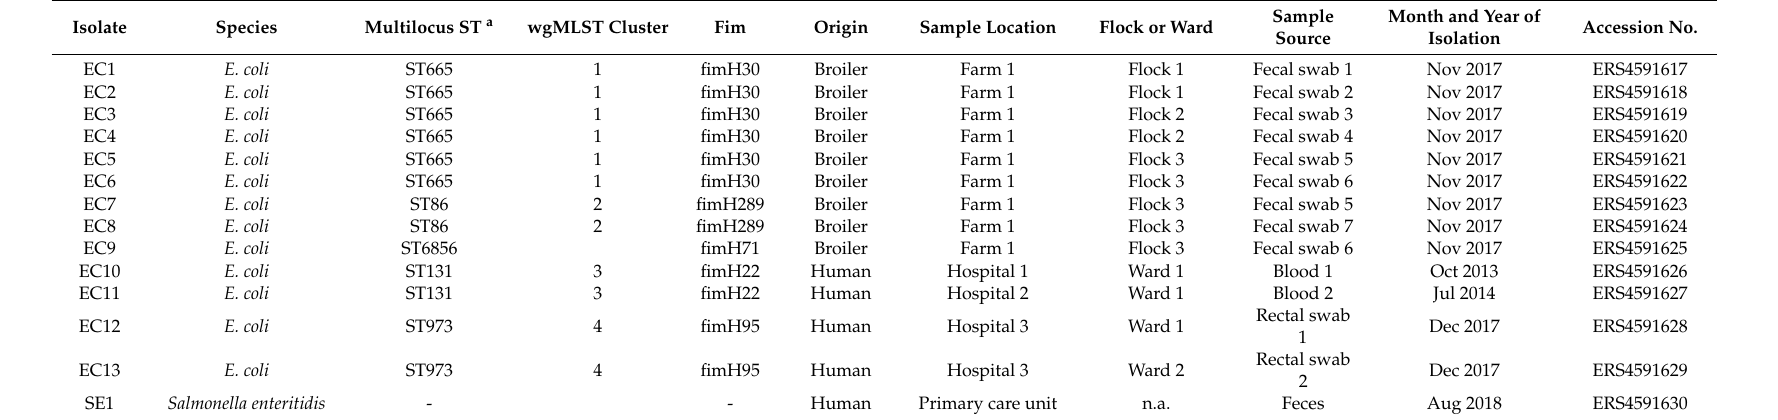
Table 1. Descriptive characteristics of fourteen IncI1–pST12 and bla CMY-2 containing